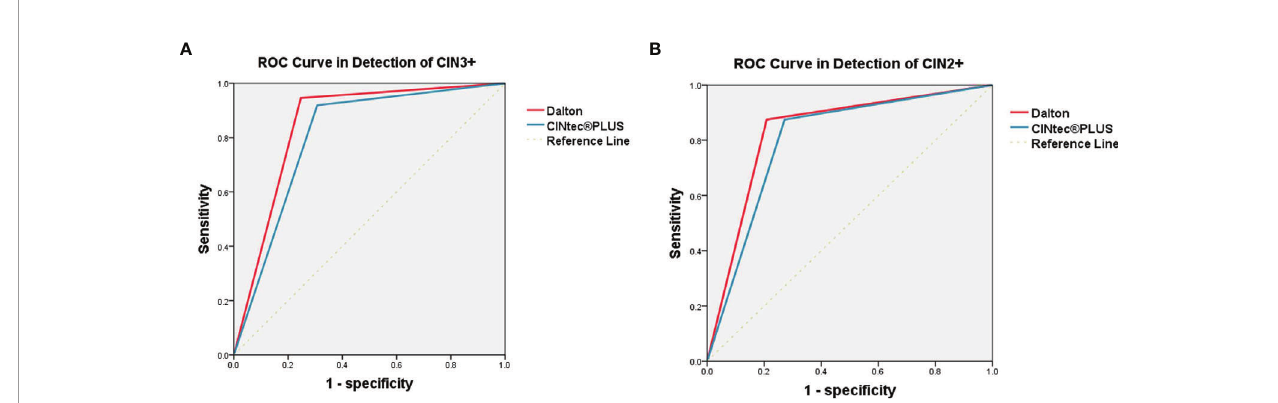
FIGURE 3 | ROC curve analysis of Dalton and CINtec ® PLUS in detecting CIN3+ (A) and CIN2+ (B) . (A) The AUC were 0.849 (95% CI, 0.800-0.899) for Dalton and 0.806 (95% CI, 0.747-0.865) for CINtec ® PLUS. (B) The AUC were 0.833 (95% CI, 0.787-0.879) for Dalton and 0.802 (95% CI, 0.754-0.849) for CINtec ® PLUS. ROC, receiver operating characteristic; CIN3+, cervical intraepithelial neoplasia grade 3 or worse; CIN2+, cervical intraepithelial neoplasia grade 2 or worse; AUC, area under the